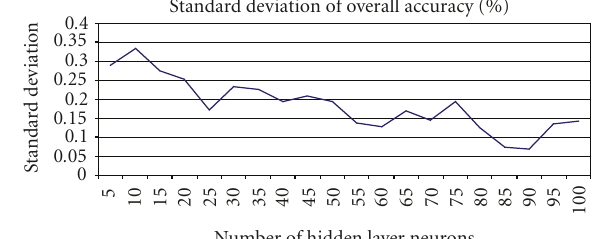
Figure 6: Standard deviation of overall accuracy versus number of hidden layer neurons of multilayer perceptron.